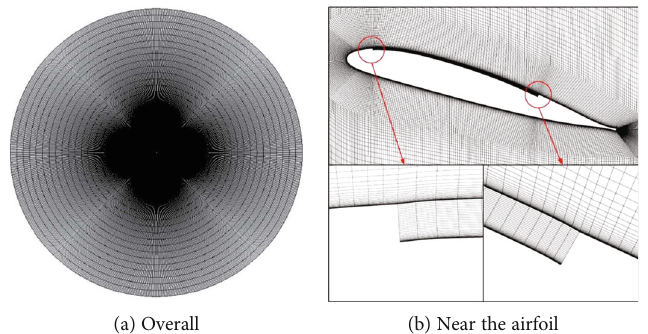
Figure 7: Computational grids of the OA212 CFJ